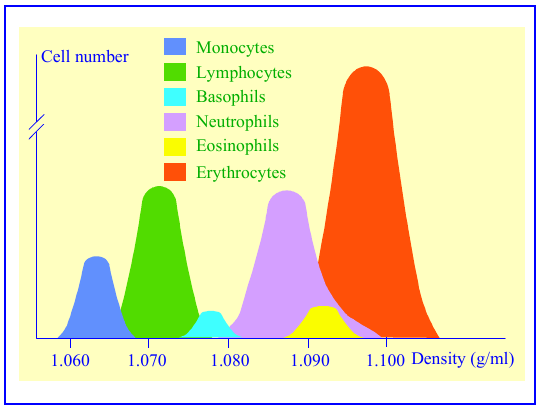
FIGURE 1 . Density of human blood